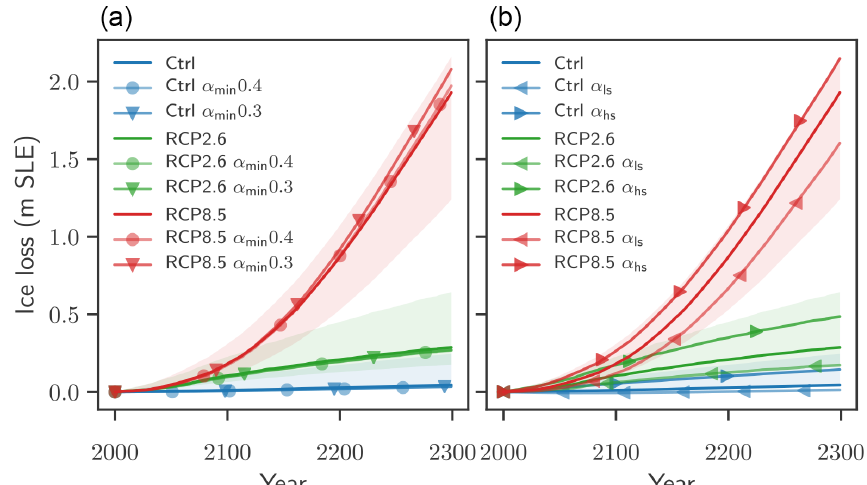
Figure 6. Uncertainty of albedo-change-driven ice loss. Ice losses of the Greenland Ice Sheet under the Ctrl, RCP2.6, and RCP8.5 scenarios, exploring the effect of different albedo sensitivities, as described in detail in Sect. 2.3.2 and Fig. A1. Shaded regions correspond to the range between the lower and upper bounds for ice loss, as shown in Fig. 5. (a) Ice losses with variations in the minimal value for albedo. Lower α min corresponds to darker bare ice. (b) Ice losses with variation in the slope of the albedo parametrization. α ls experiments use a lower slope (half of the standard value); thus the sensitivity of albedo to melt is reduced. α hs experiments use a higher slope (double the standard value), thus increasing the sensitivity of albedo to melt. Ice loss is given in metres of sea level equivalent. A value of 1ms.l.e. corresponds to approx. 361800Gt of